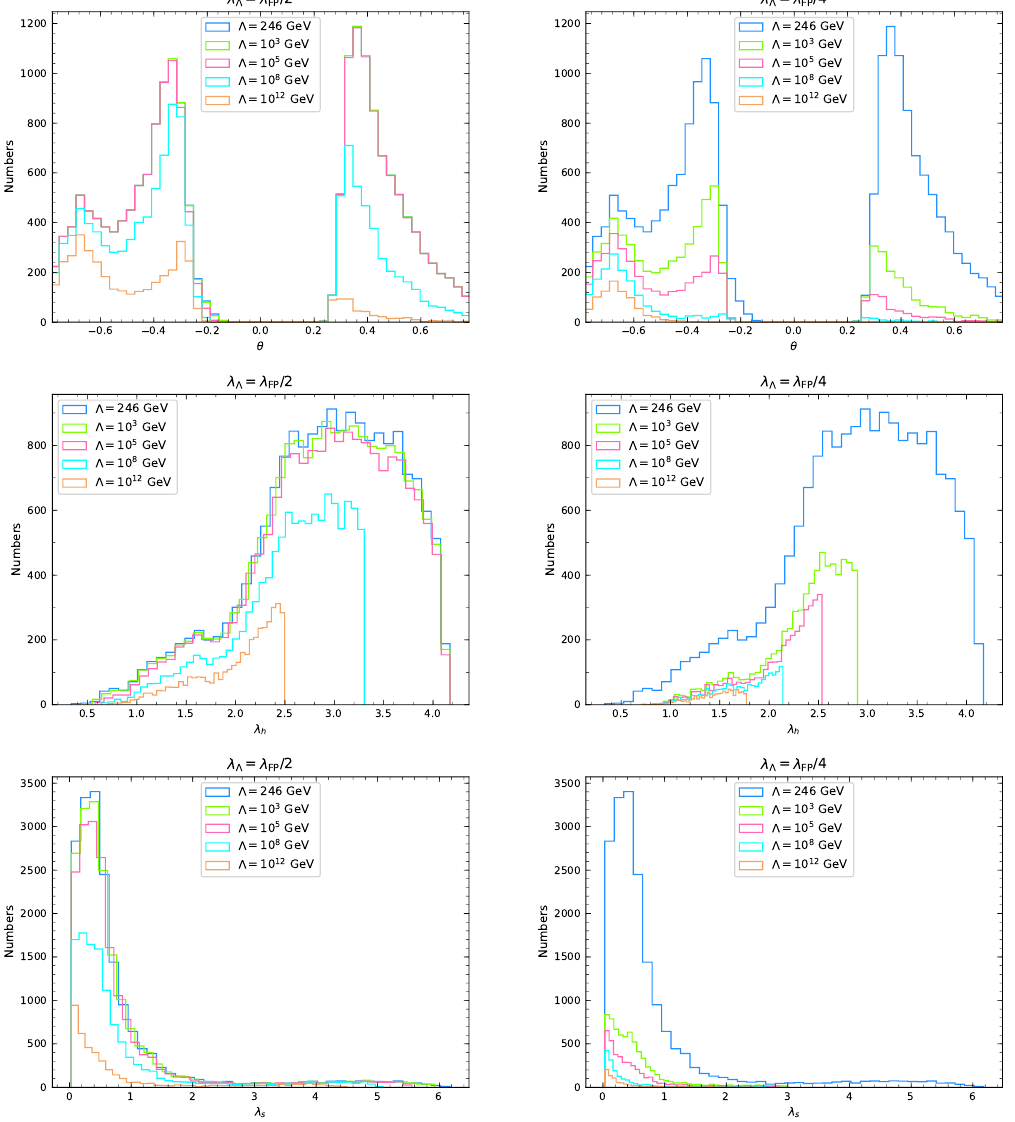
Figure 5 . Distributions of parameters after taking into account the constraints from vacuum stability and perturbativity at the one-loop level. The blue, green, pink, light blue, and yellow histograms represent the bounds with (cid:3) = 246 GeV, 10 3 GeV, 10 5 GeV, 10 8 GeV, and 10 12 GeV, respectively. (cid:21) (cid:3) = (cid:21) FP = 2 for the left plots and (cid:21) FP = 4 for the right